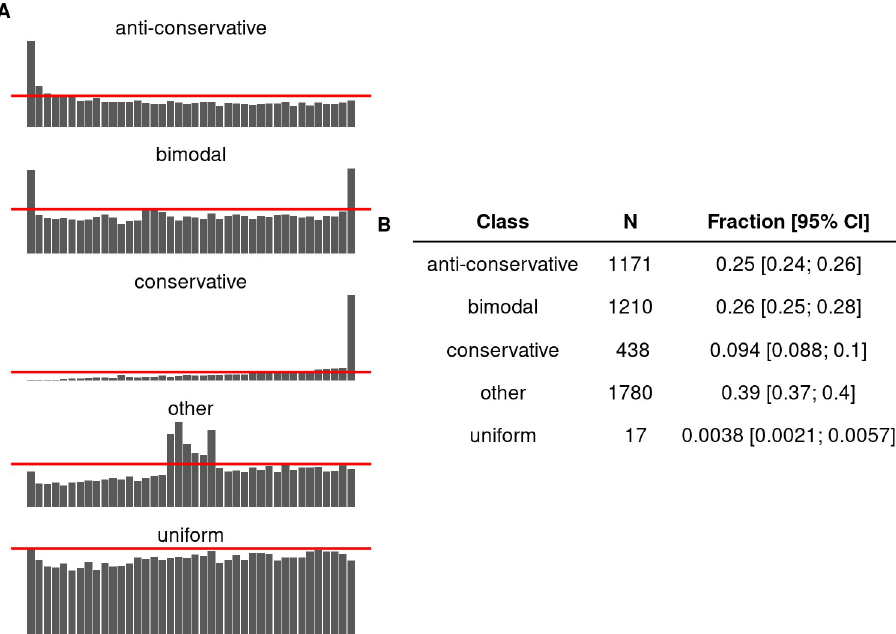
Fig 1. Classes of p -value histograms. ( A ) Examples of p -value histogram classes. Red lines denote the algorithmic threshold separating p -value histograms into discrete classes. ( B ) Summary of p -value histograms identified from GEO supplementary files. One p -value set was randomly sampled from each GEO series where p -values were identified. N = 4,616; 95% CI are credible intervals. The model object related to panel B can be downloaded from https://gin.g-